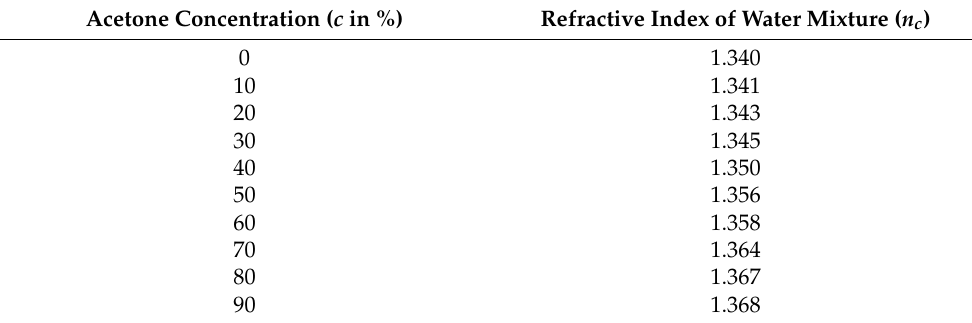
Table 1. The refractive index of different water mixtures of acetone concentration ranging from 0 to